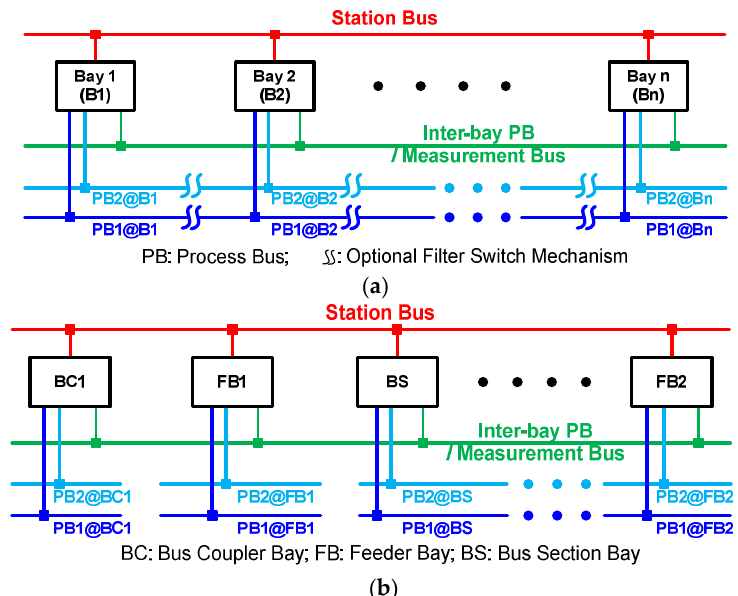
Figure 1. High-level view of the proposed PAC architecture: ( a ) Generic PAC architecture with filter switches (optional) for linking or isolating process bus bays and ( b ) PAC system architecture for double busbar with intendent process bus bay.